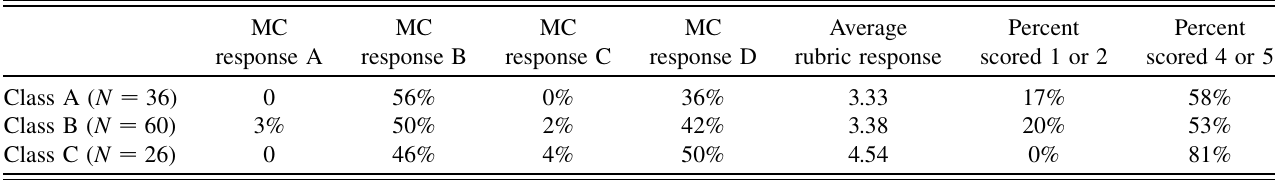
TABLE IV. Post-test data for percentage of preservice immersion participants’ answers for each possible response to question in Fig. 1 and rubric scores for class.